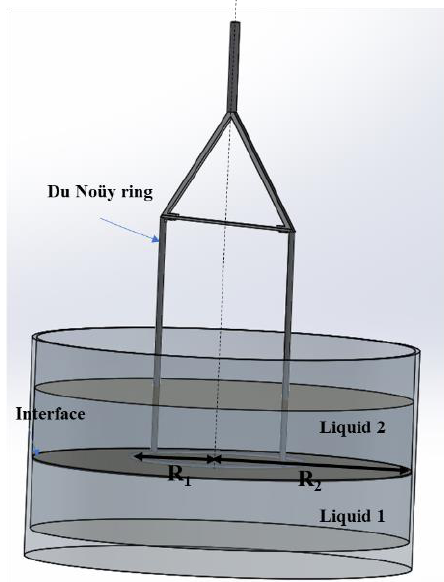
Figure 10. Profile section of the Du Noüy ring